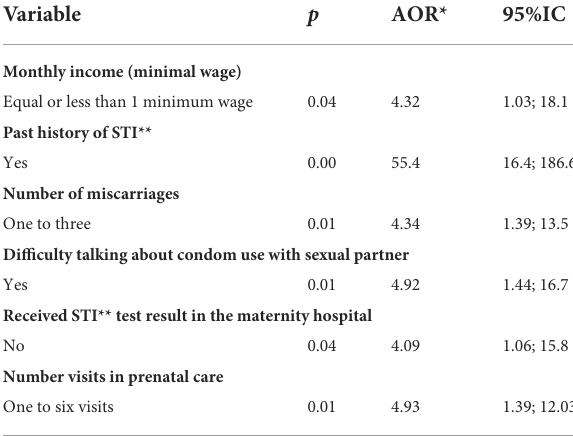
TABLE 4 Results of the multiple logistic regression analysis between factors and gestational syphilis, in the Brazilian Amazon, 2020–2021. Variable